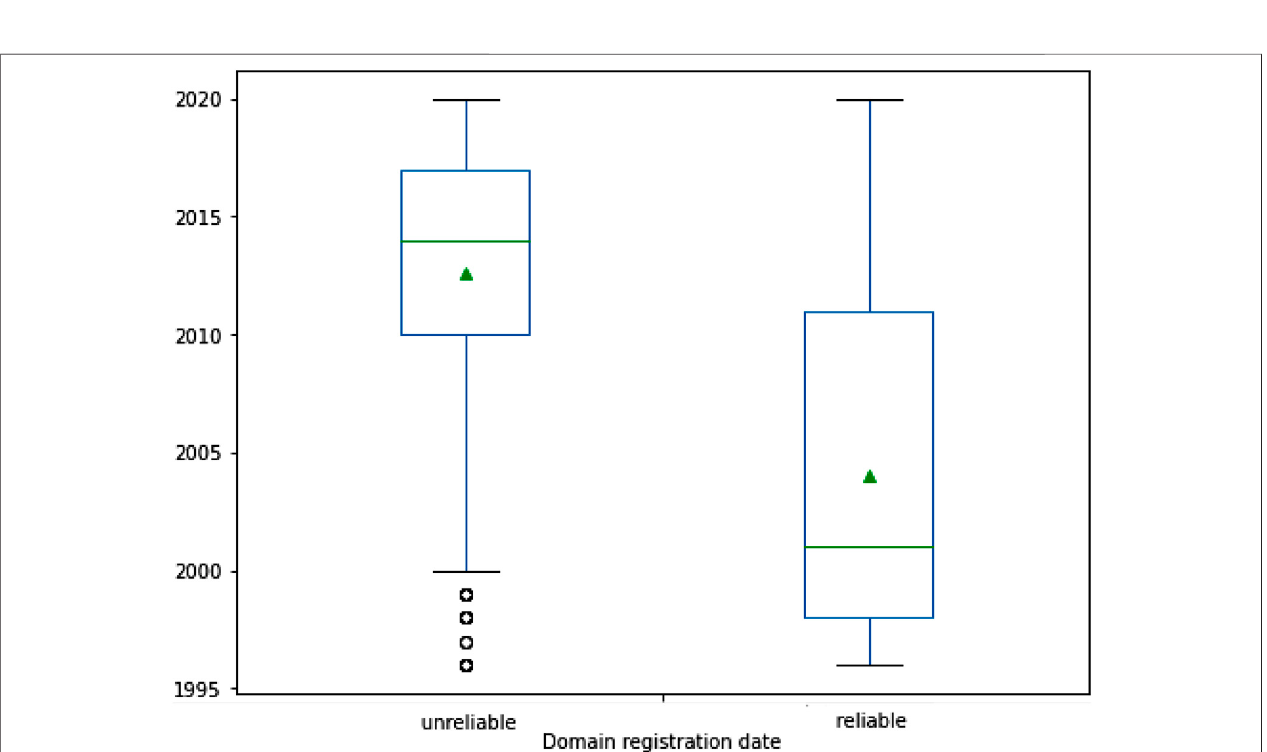
FIGURE 8 | Box plots denoting the distribution of domain registration dates to unreliable and reliable news sources. Box plot shows fi ve statistics: the minimum value (at the end of the lower whisker),the fi rst quartile (the bottom of the box), the median (the line in the box), the third quartile (at the top ofthe box), and the maximum value (at the end of the upper whisker). The mean value is indicated by a small triangle in the box. Data distribution is skewed to the left in the unreliable data, where the meanislessthanthemedian. Unreliablenewssourcesgenerallyhavemorerecentregistration datesthanreliableonesthatinsteaddeveloped theirreputationover the years. Outliers are present in the unreliable dataset: they are indicated by small circles outside the box. (cid:129) Median: it is shown as a line that divides the box into two (cid:129) Maximum: it is shown at the top of the box, at the bottom of parts; the upper whisker; (cid:129) Mean: it is indicated by a triangle in the box; (cid:129) Outliers: if any, they are indicated by small circles outsides (cid:129) Third quartile (75th percentile): it is shown at the top of the box; the box.